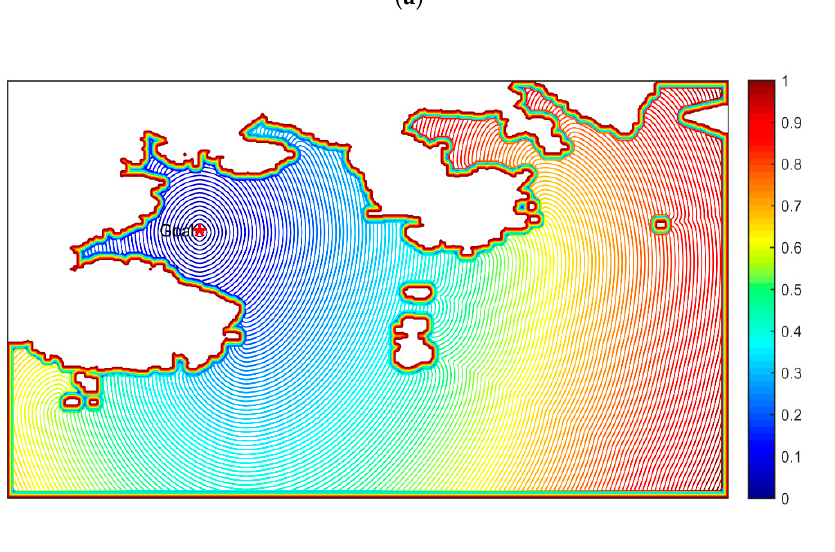
Figure 13. Static modeling: ( a ) static environment field M static ; ( b ) static full potential field M PF